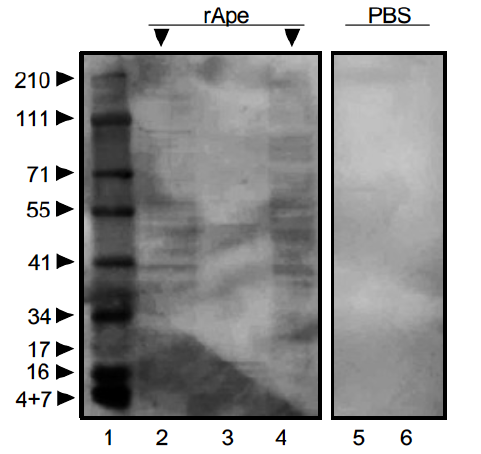
Figure 6 . rApe interacts with cell lysate and membrane fractions. Composite picture of a Far-Western blot detecting Ape protein. Lysate and cell fractions were separated by SDS-PAGE, transferred to PVDF and incubated either with rApe (left panel) or PBS as a negative control (right panel). The Western blot was probed with rabbit anti-GFP-HRP antibody, and revealed by peroxide substrate mixed with chromogen DAB. 1: protein ladder, 2 and 5: cell lysates, 3: cytoskeleton fraction, 4 and 6: membrane and organelles fractions.